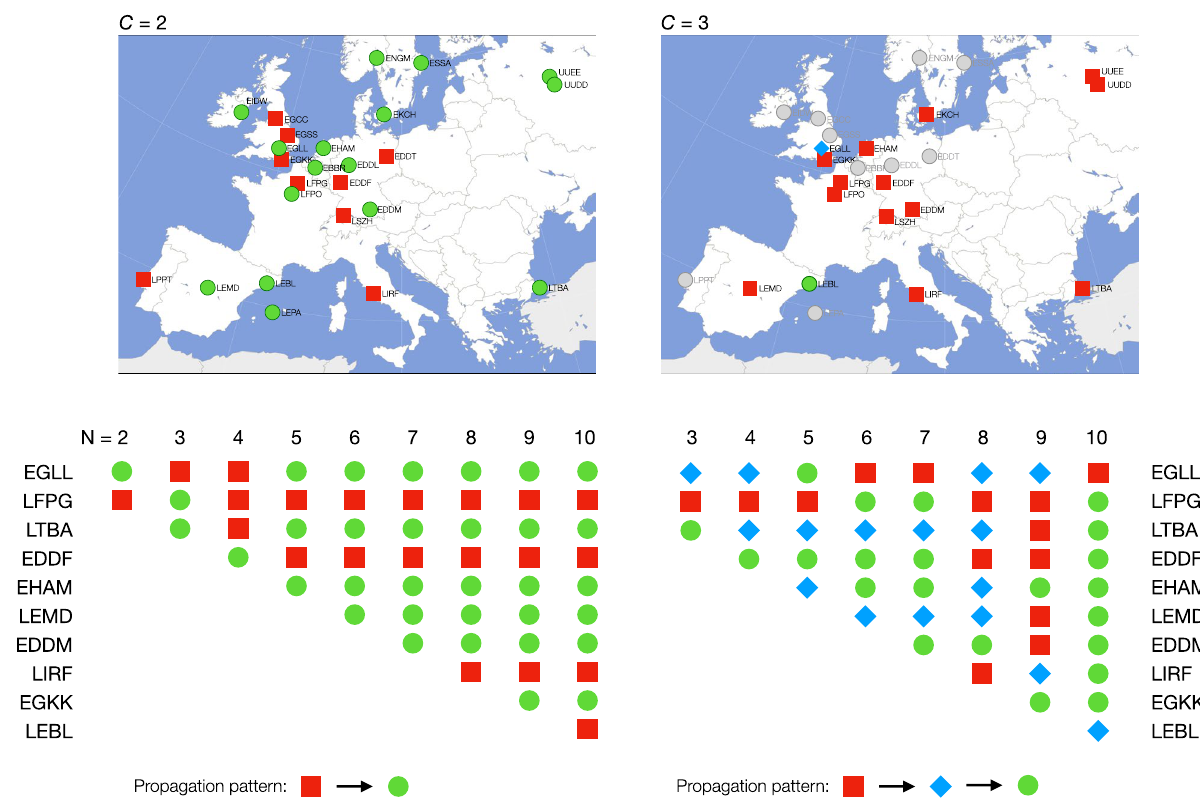
Figure 7. Analysis of delay propagation patterns in air transport. The top panels represent the clustering of the 25 largest European airports, respectively for C = 2 (left) and C = 3 (right). The color and shape of each airport represent its detected role, including net forcing (red squares), intermediary (blue diamonds, only for C = 3 ) and net forced (green circles). Note that only the first 15 airports have been considered for C = 3 , due to the large computational cost; all other airports are marked in grey. Both maps were originally obtained from https:// commo ns. wikim edia. org/ wiki/ File: Europe_ polar_ stere ograp hic_ Cauca sus_ Urals_ bound ary. svg with license https:// creat iveco mmons. org/ licen ses/ by- sa/3. 0/ deed. en, and modified by using Keynote 11.0 software. The bottom panels report the evolution of the role of airports, as a function of the number of airports included in the